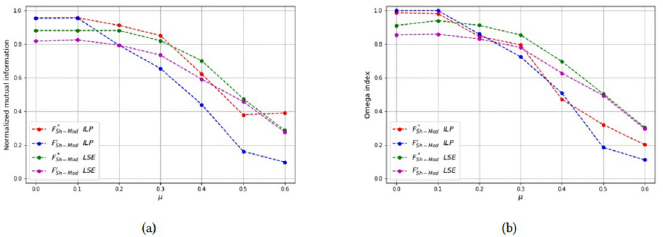
Fig 12. Test results on non-overlapping communities, parameters N = 40, n method, (b) Average Omega for each solution